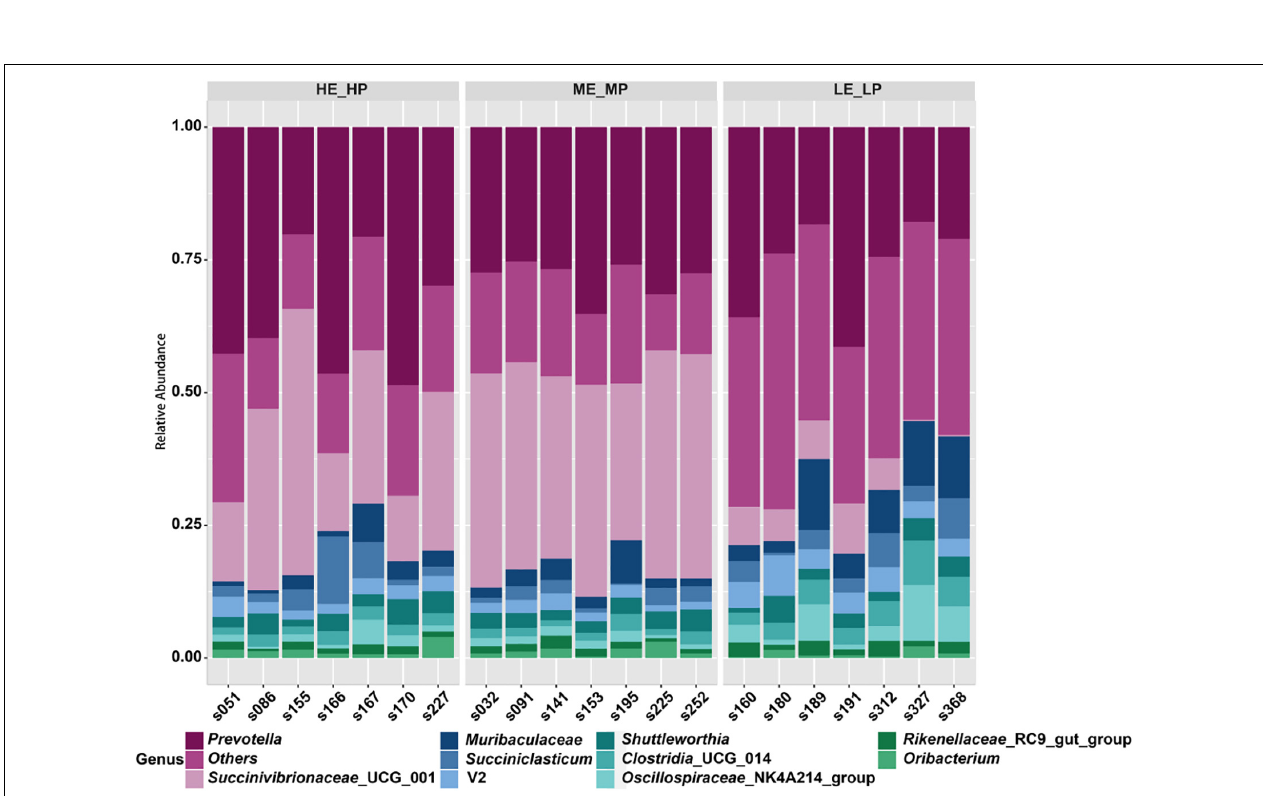
FIGURE 4 | Relative abundances of rumen microbiota at the genus level among the HE_HP cows, ME_MP cows, and LE_LP cows.